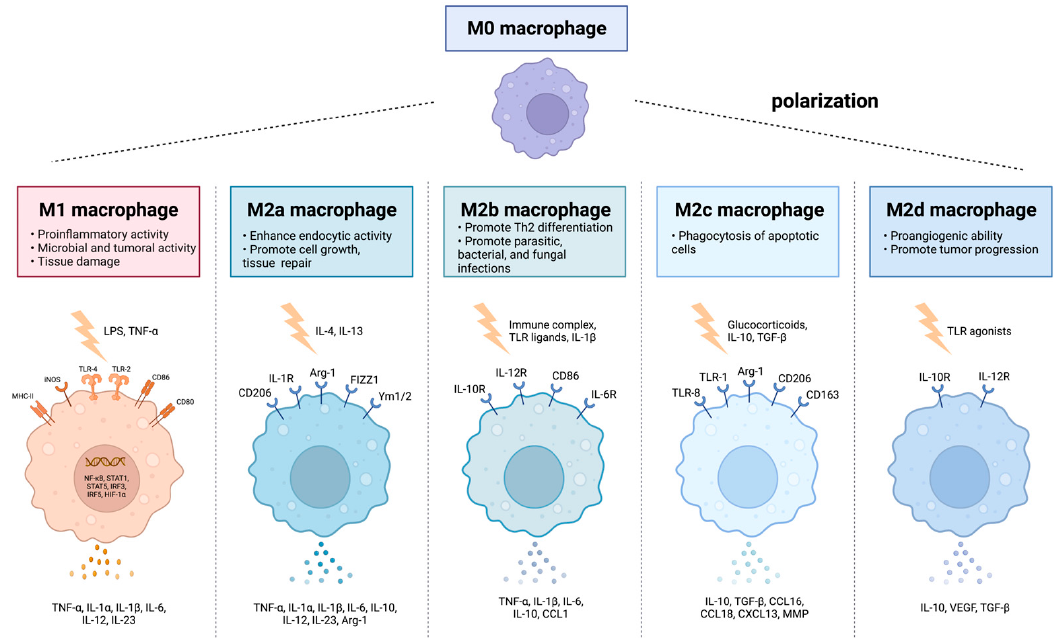
Figure 3. Macrophages have been characterized as unpolarized M0, pro-inflammatory M1 pheno- types, and anti-inflammatory M2 phenotypes (M2a, M2b, and M2c) with different functions. Created with BioRender.com.